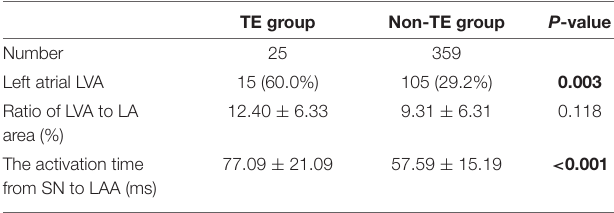
TABLE 2 | The prevalence of left atrial LVA, ratio of left atrial LVA to LA area, and the activation time from SN to LAA. TE